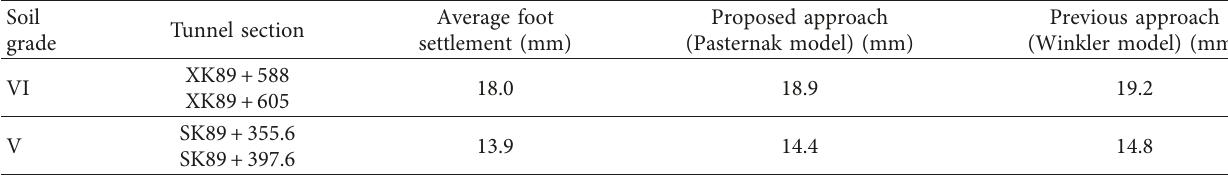
Table 4: Comparison of the predicted foot settlements.